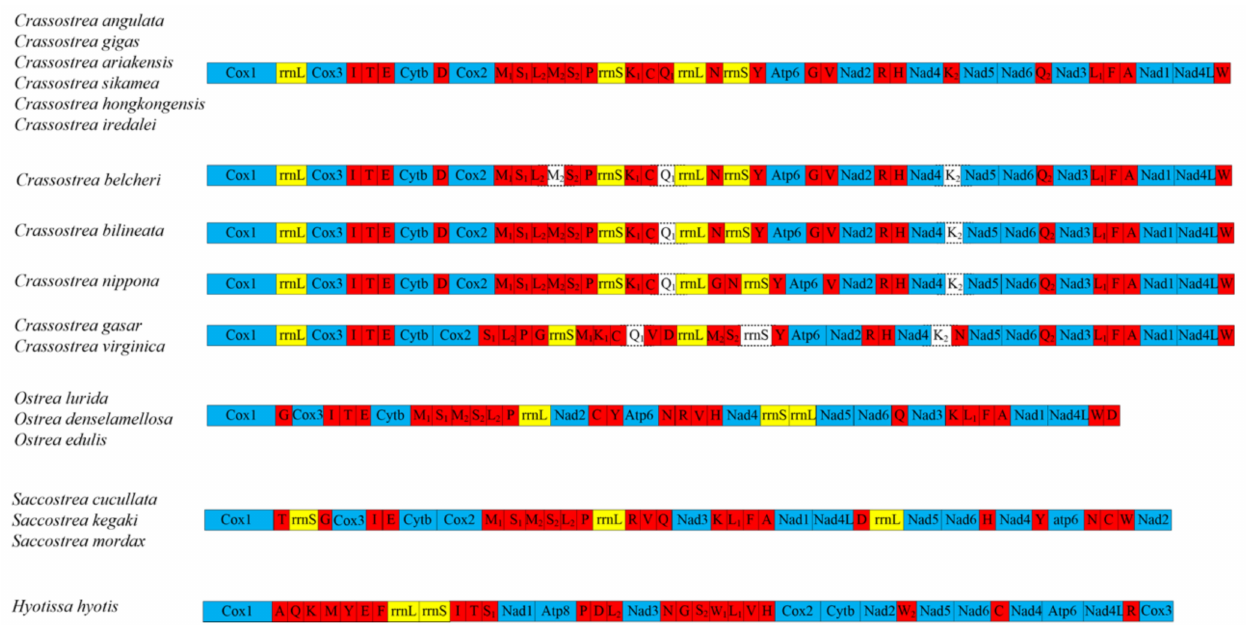
Figure 4. Linearized mitochondrial gene orders of the represented oyster mitogenomes available on GenBank (Accession numbers are provided in Table 1). tRNA genes are marked by the single-letter codes of the encoded amino acids. tRNAs in the dashed box means the missing genes compared with the congeneric